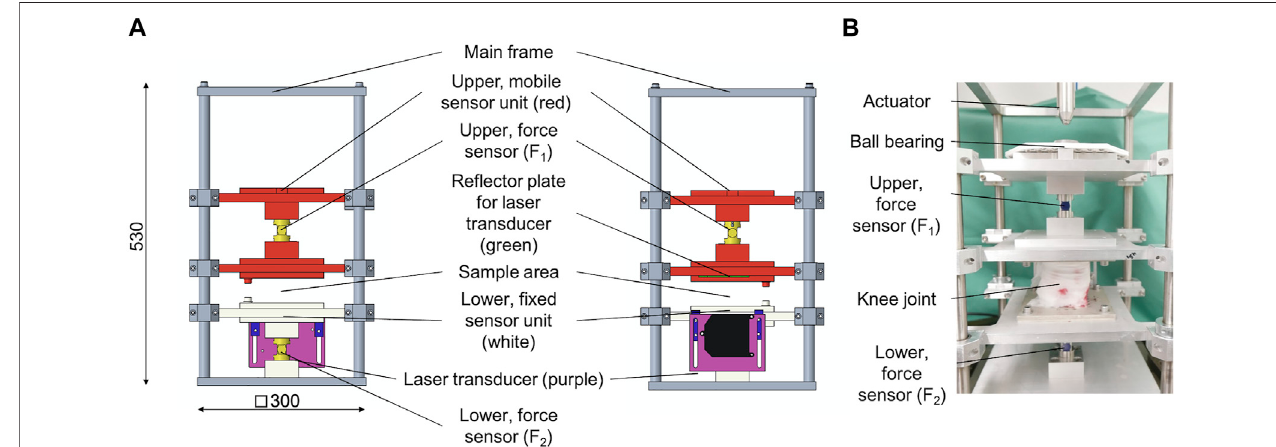
FIGURE 4 | (A) Technical drawing of the modi fi ed dynamic mechanical analysis (DMA) setup in side (left) and frontal (middle) view. The upper, mobile sensor unit (red)isaxiallyguidedbyeightaxialballbearingsandincorporatestheupperforcesensor.Onitstop,thereisamultiaxialballbearingtoprotecttheloadcellofthedynamic testingmachine,whileatthelowerend,thereisare fl ectorplate(green)foralasertransducerinstalled.Thelower, fi xedsensorunit(white)isaxiallyguidedbyfouraxialball bearings and incorporates the lower force sensor as well as an external, high-precision laser length transducer. The lower end of this sensor unit is directly connected to the main frame. (B) Example of an installed porcine knee joint at the sample area at the DMA setup.